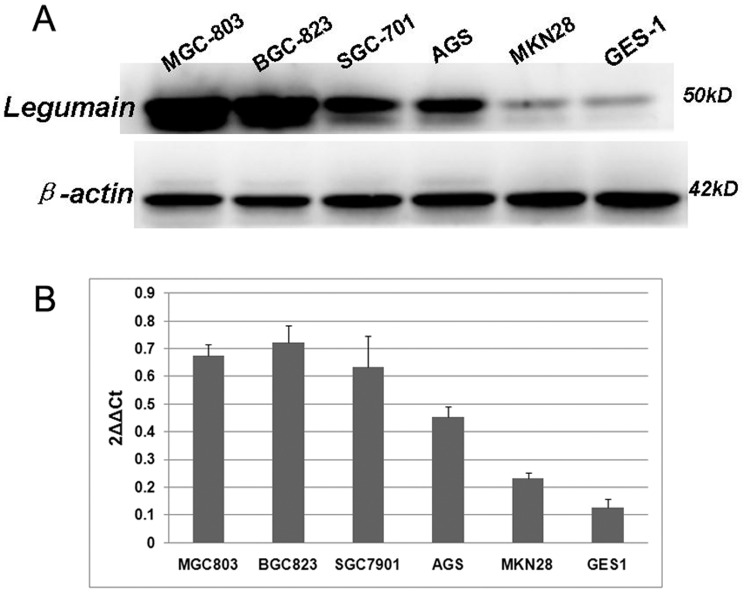
Legumain expression at the mRNA and protein levels.(a) Western blotting analysis of Legumain in normal gastric cell lines (GES-1) and gastric cancer cell lines (MKN28, AGS, SGC-7901, MGC-803, BGC-823). BGC-823, MGC-803 cell (poorly differentiated) and AGS, SGC-7901 (moderately differentiated) showed lower expression of Legumain in comparison with GES-1 (normal gastric cell lines) and MKN28 (well differentiated), (b) β-actin is the loading control. Legumain expression was confirmed in all the cell lines by realtime PCR.